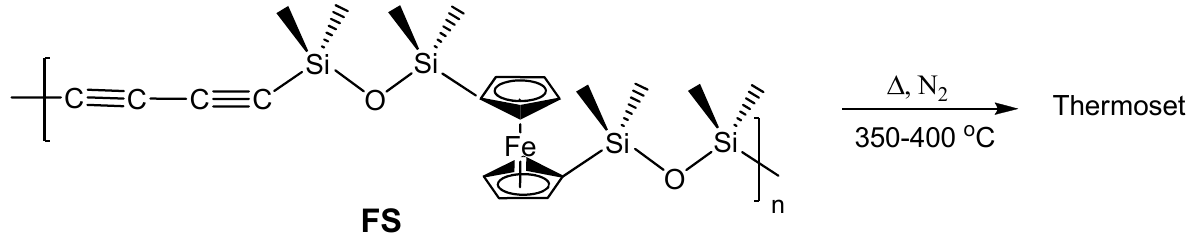
Figure 8. The diacetylene-containing ferrocenylsiloxane polymer FS and its conversion into a thermoset by heating. Adapted from Ref. [8] with permission from American Chemical